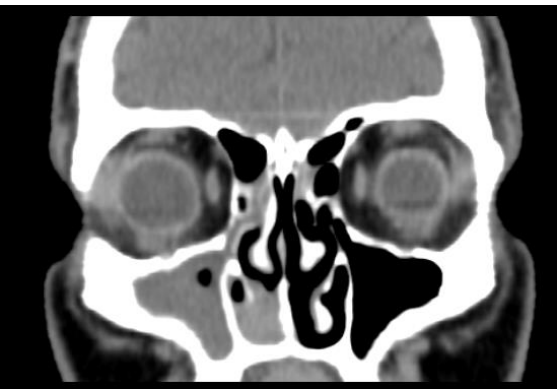
Figure 1. Preoperative CT scan showing a nonspecific opacification of the right nasal fossa (inferior meatus) with partial erosion of the inferior turbinate. There was no evidence of invasion into the skull base, cribriform plate, or olfactory cleft. The CT scan demonstrated density and mucosal thickening of the maxillary sinus.